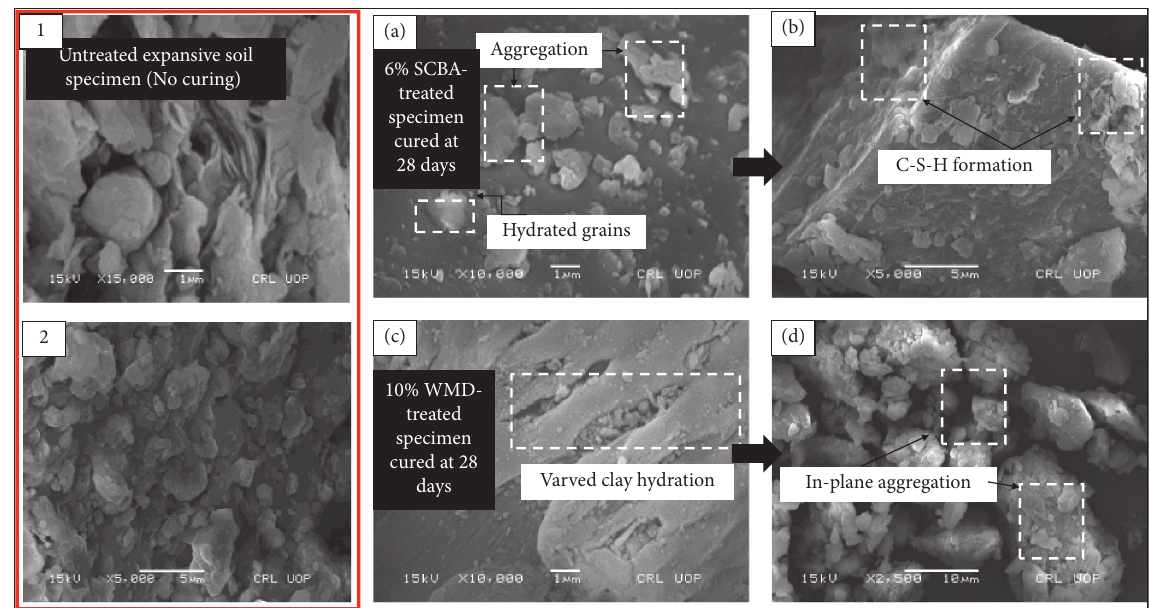
Figure 6: SEM in-plane micrographs for untreated and treated (6% SCBA and 10% WMD) expansive soil. Table 2: Oxides compositions of Ca-based soil stabilizer materials (CSMs) from the past literature versus those used in this study. Ca-based soil stabilizers Constituents (%) Sugarcane bagasse ash, SCBA